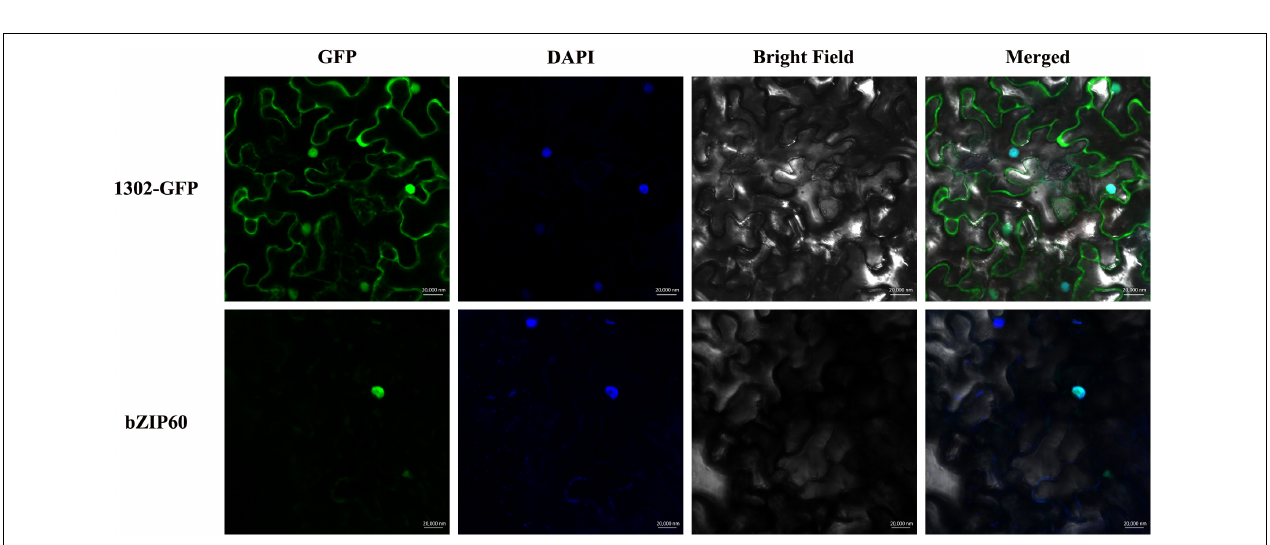
FIGURE 9 | Subcellular localization of SpbZIP60. The SpbZIP60-GFP fusion construct and the GFP gene driven by the CaMV 35S promoter were transiently expressed in tobacco. The nucleus was visualized using the DAPI staining solution.